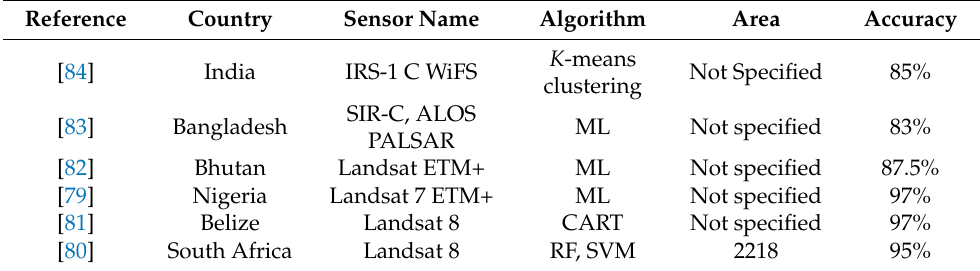
Table 4. Forest cover mapping and change